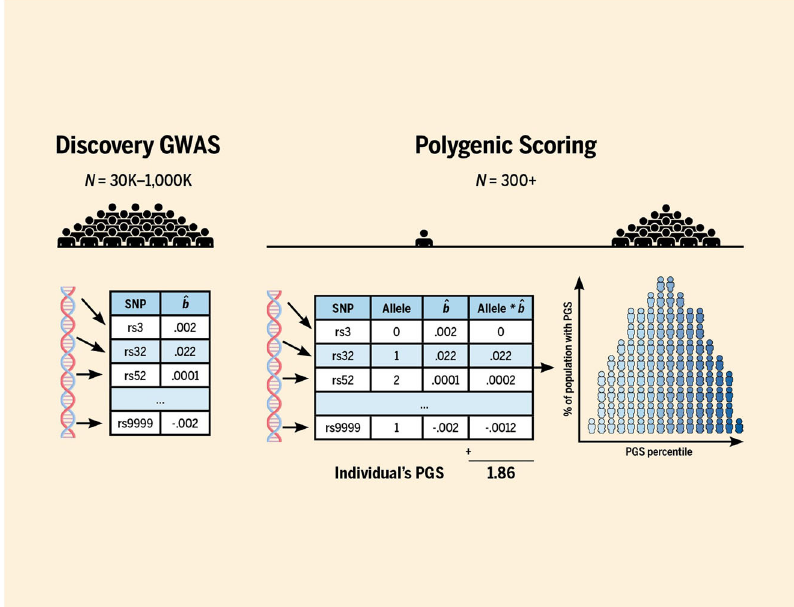
Fig. 6 A polygenic score (PGS) indexes an individual ’ s genetic predisposition for a cerain trait or disease (see also 68 ). Left panel: A published genome-wide association study (GWAS) serves as an external database. In an extremely large sample, a GWAS estimates tiny ^ b ) between the trait of interest and millions of genetic variants. Speci fi cally, the genetic variants studied are single-nucleotide associations ( polymorphisms (SNPs), located across the genome. Middle panel: Polygenic scoring can be done in a sample that was not part of the GWAS. ^ b ) are multiplied by the number of trait-associated alleles (0, 1, or 2) the person carries. For each individual in this sample, the SNP effects ( These values are summed across all SNPs to arrive at the individual ’ s PGS. Right panel: The resulting PGSs across individuals in that sample are normally distributed. If the trait of interest is a disorder, like ADHD, the individuals in the right tail have the highest genetic risk for developing ADHD. PGSs are not yet strong enough for predictions at the individual level, but see the main text for examples of how PGSs advance science at the group level. Figure adapted from ref. 69 . Figure by ref. 66 available at https://bit.ly/2BPcCXP under a CC BY 4.0